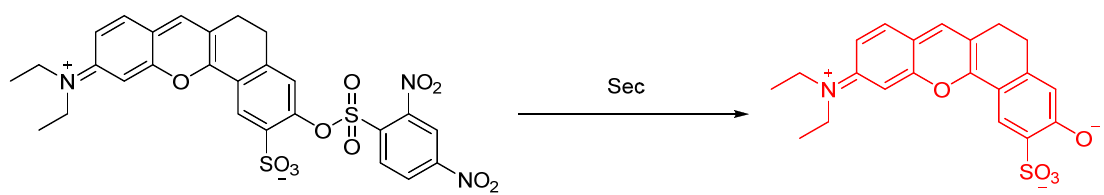
Figure 57. The reaction of the O–hNRSel fluorescence probe by Zhang et al. and its selective reaction with selenocysteine.